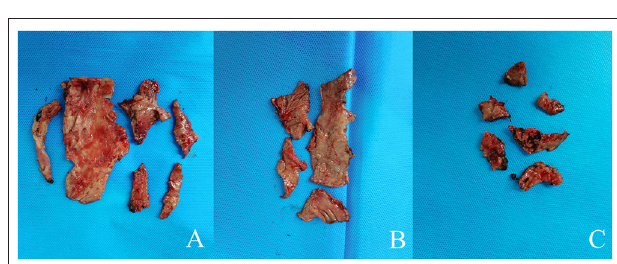
FIGURE 4 | Image showing theparietal pleura (A) , the visceral pleura (B) , and the diaphragm surface (C)